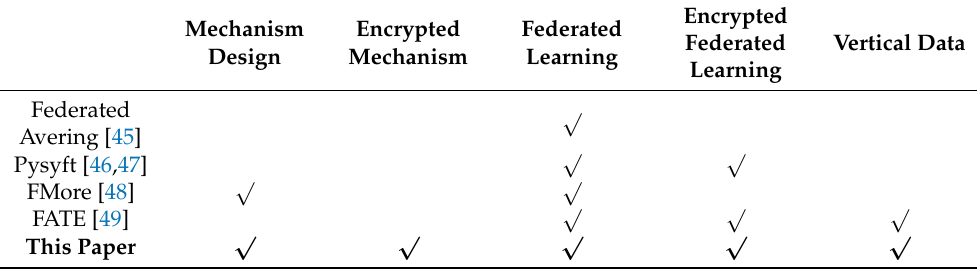
Table 3. Comparison with state − of − the − art algorithms.